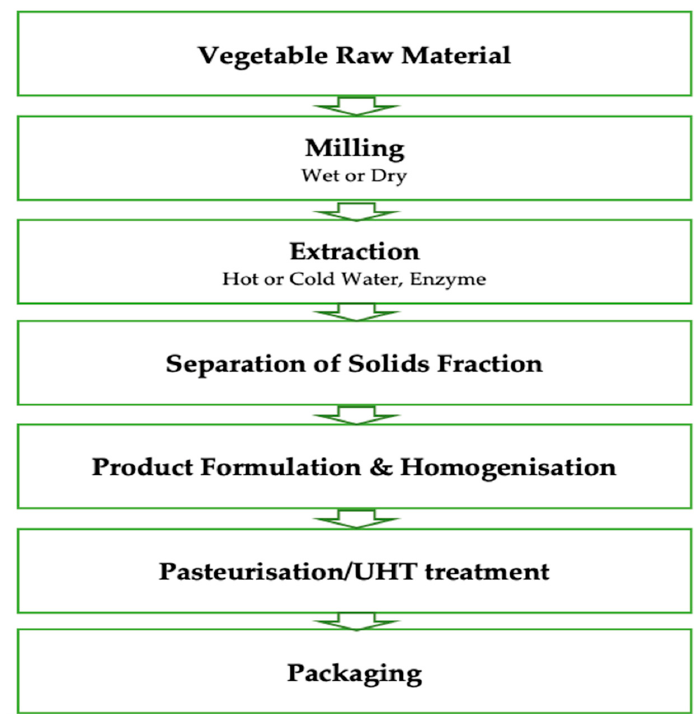
Figure 1. General flow chart for vegetable milks production .